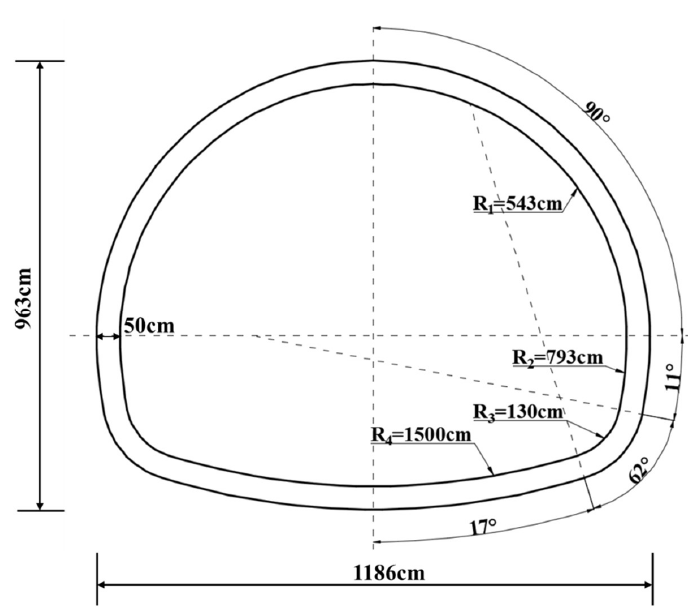
Figure 2. Tunnel secondary lining prototype section dimensions.